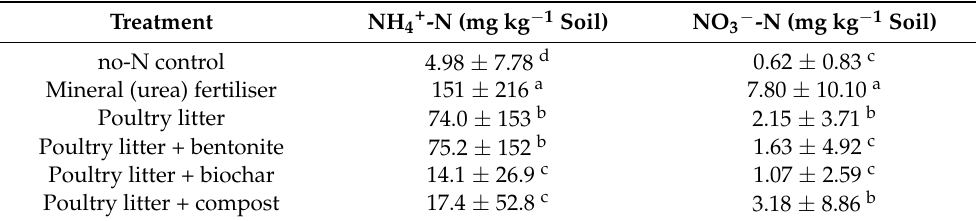
Table 1. Mean concentrations ( ± SD; n = 75) of soil ammonium (NH 4+ ) and nitrate (NO 3 − , mg N kg − 1 ) of sugarcane rows of the first 130 days of the field experiment. Statistical analysis was a ‘repeated measures one-way ANOVA with Fisher’s LSD post-hoc test’ after log-transformation of the data. Significant differences between treatments ( p < 0.05) are indicated with different letters within columns.